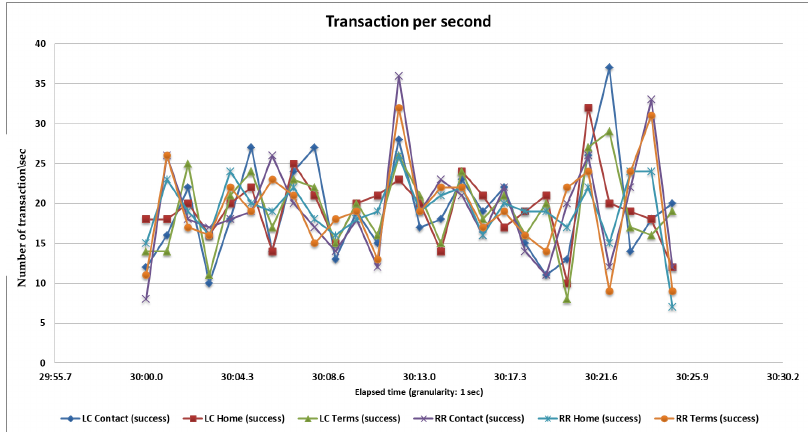
Figure 13. Throughput or transactions per second of the RR and LC algorithms.